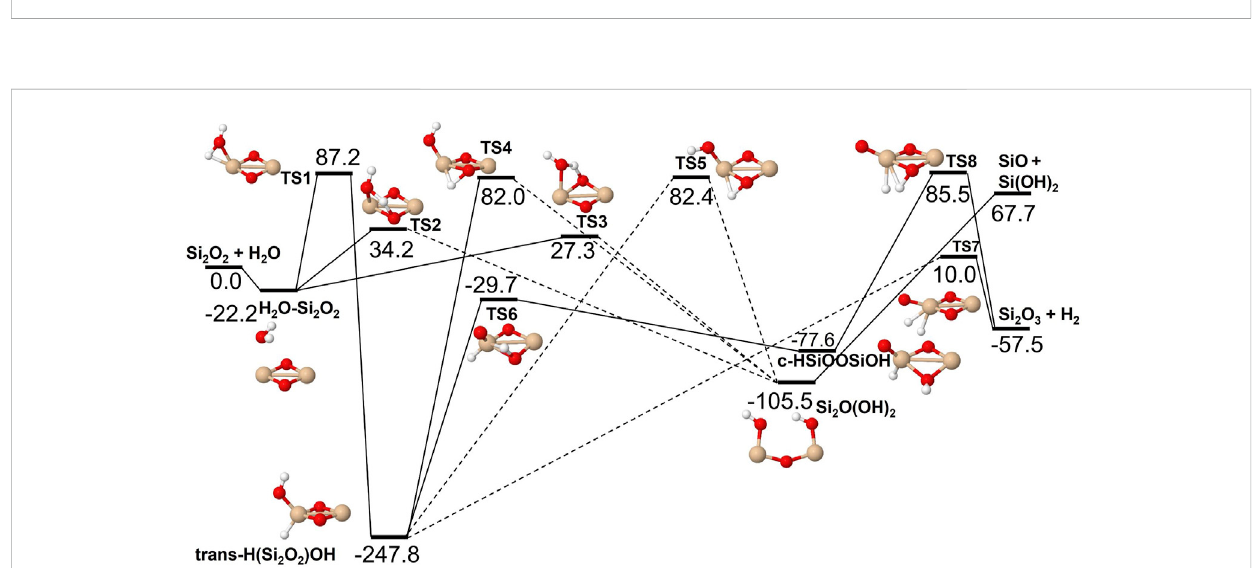
FIGURE 4 PotentialenergysurfacebasedonM06calculationsfortheSi 2 O 2 +H 2 OreactionasimplementedintheRRKMcalculations.Theenergiesaregivenin kJ/mol and include zero-point energy corrections. Dashed lines indicate that the reaction step has been simpli fi ed by combining several similar intermediate